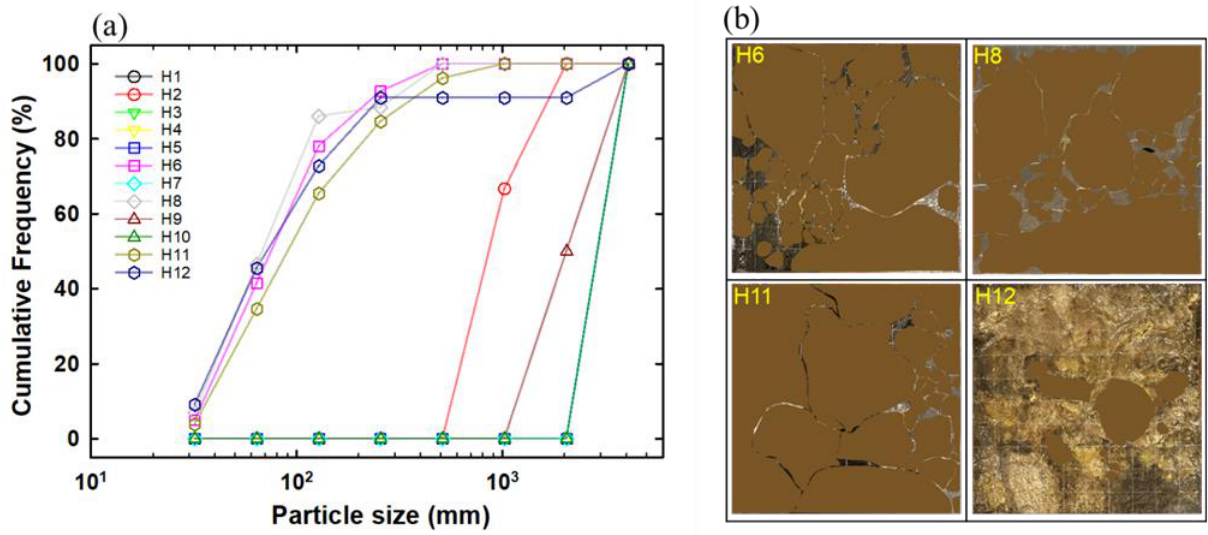
Figure 4. Cumulative grain-size frequency curves ( a ) with indicated percentile values and shading of bed materials ( b ) to compute the size of the sediment. Table 1. Physical factors, distance from a reference point (H1), temperature, flow velocity (u), water depth (h), and the median of the bed substrate sizes (D 50 ), of each surveyed, reach in the river.